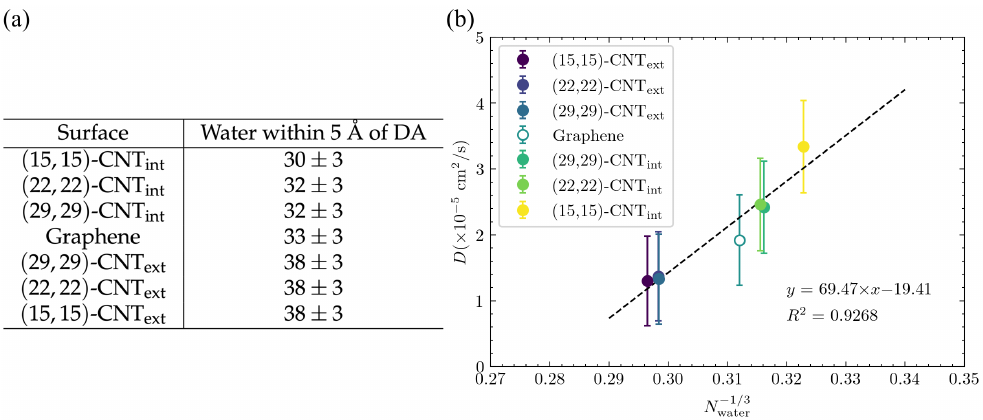
Figure 11. Correspondence between CNT surface, solvating waters, and D . ( a ) The number of waters in the first solvation shell around DA are calculated across the different surfaces. For a given water molecule, its distance to DA is the shortest distance between its oxygen atom and any the atoms of DA. Only the water molecules that are on the same side of the surface as DA are counted. N water and its statistical errors were computed from 10 trajectories. ( b ) The diffusion constants, D , from Figure 3c are plotted vs. N − 1/3 water for DA on a range of differently curved surfaces. A linear fit line is shown here along with the coefficient of determination, R 2